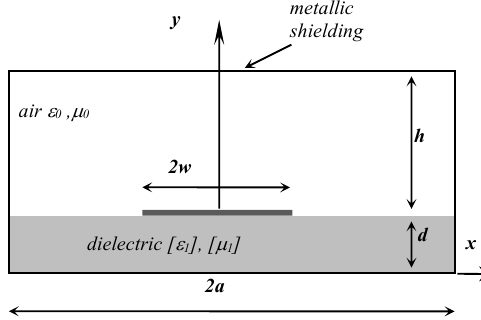
Figure 1: Configuration of a shielded